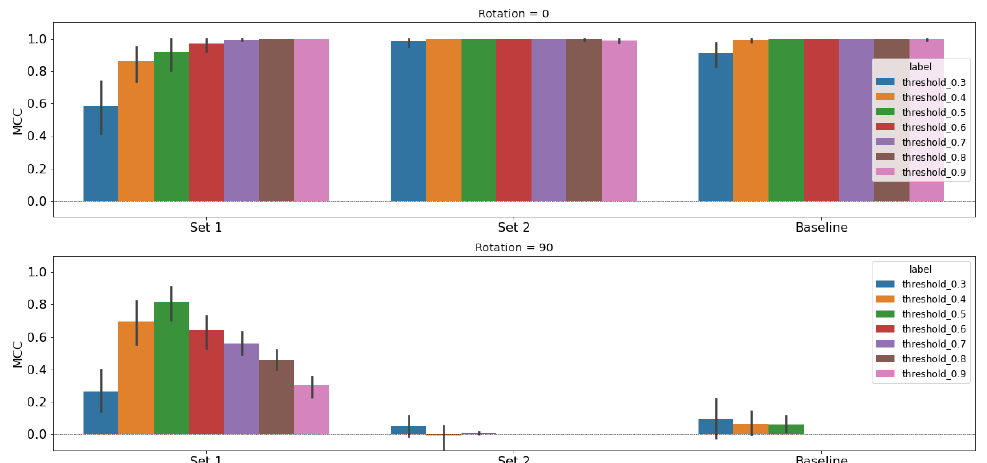
Figure 14. Performance study results for X-band using the unet classifier architecture. Each model is trained with an even split of augmented and non-augmented images, then tested on 0 ◦ rotated images ( top row ) and 90 ◦ rotated images ( bottom row ). We use the MCC metric and a sweep of thresholds to present a profile of performance rather than single metric. Training augmentations are chosen from the 2D latent space representations. Set 1 chooses based on the 90 ◦ /270 ◦ look angle images, and Set 2 chooses based on the 0 ◦ /180 ◦ look angle images. The baseline model performance is on the far right for